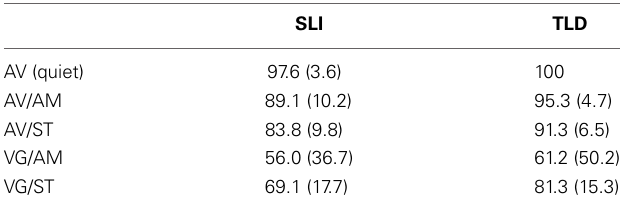
Table 4 | Mean percent correct responses for AV in quiet, in AM noise, and ST noise, and mean value for Visual Gains (VG).